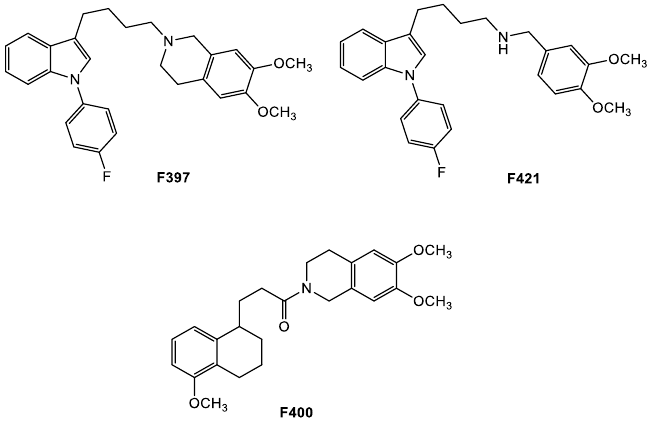
Figure 1. MRP1 modulators from the sigma-2 receptor library .